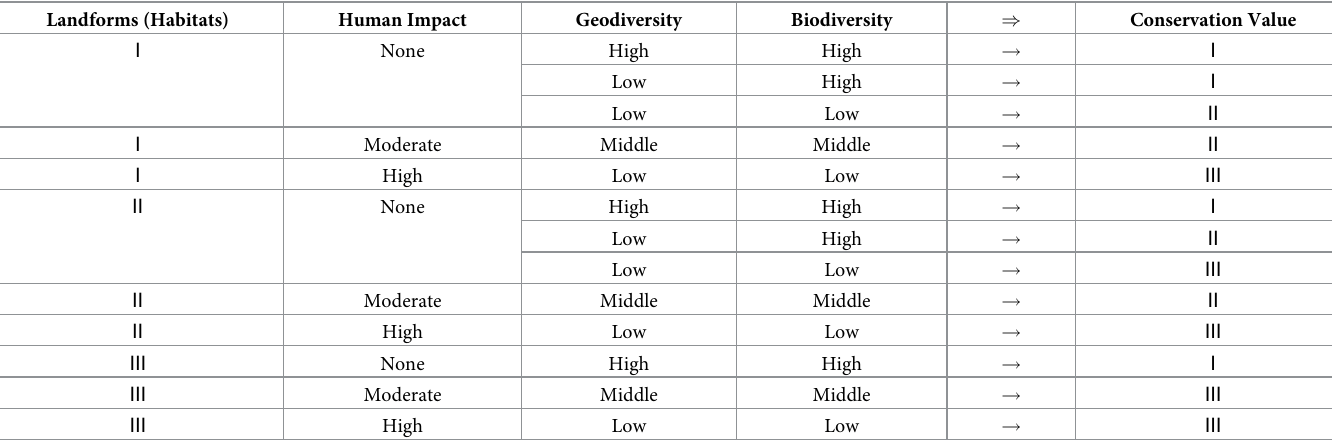
Table 8. Conservation criteria for each of the landform categories. Landforms